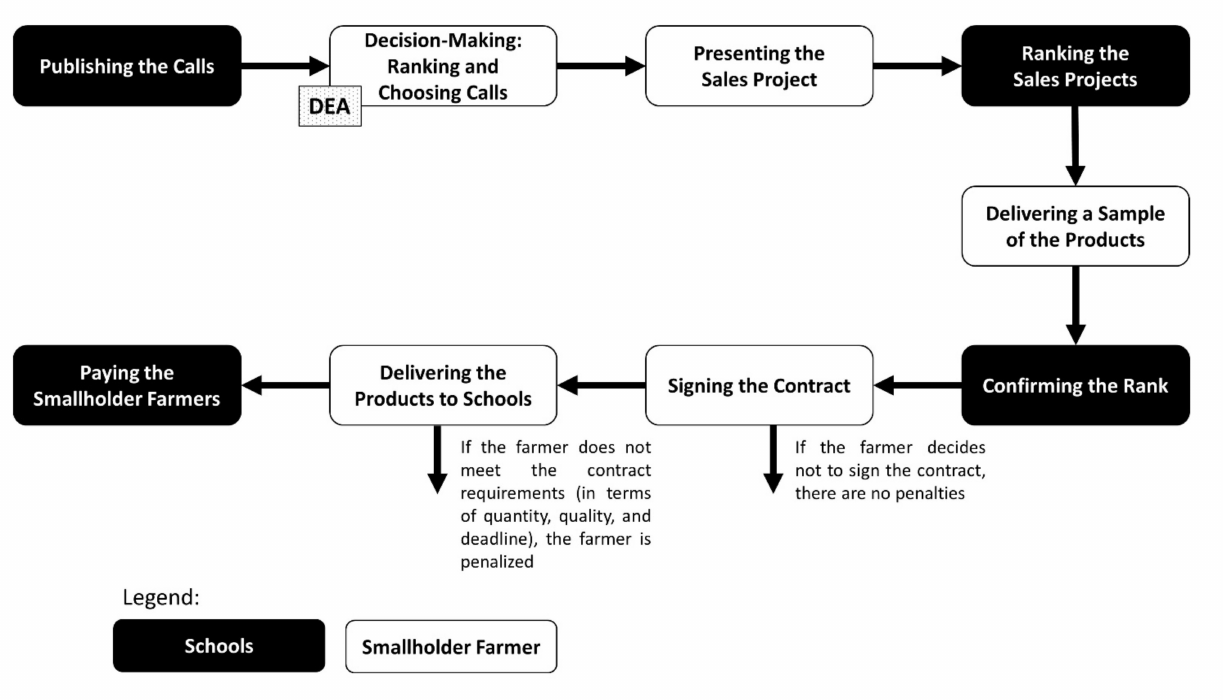
Figure 1. Illustration of the PNAE process and Decision Making of the Smallholder